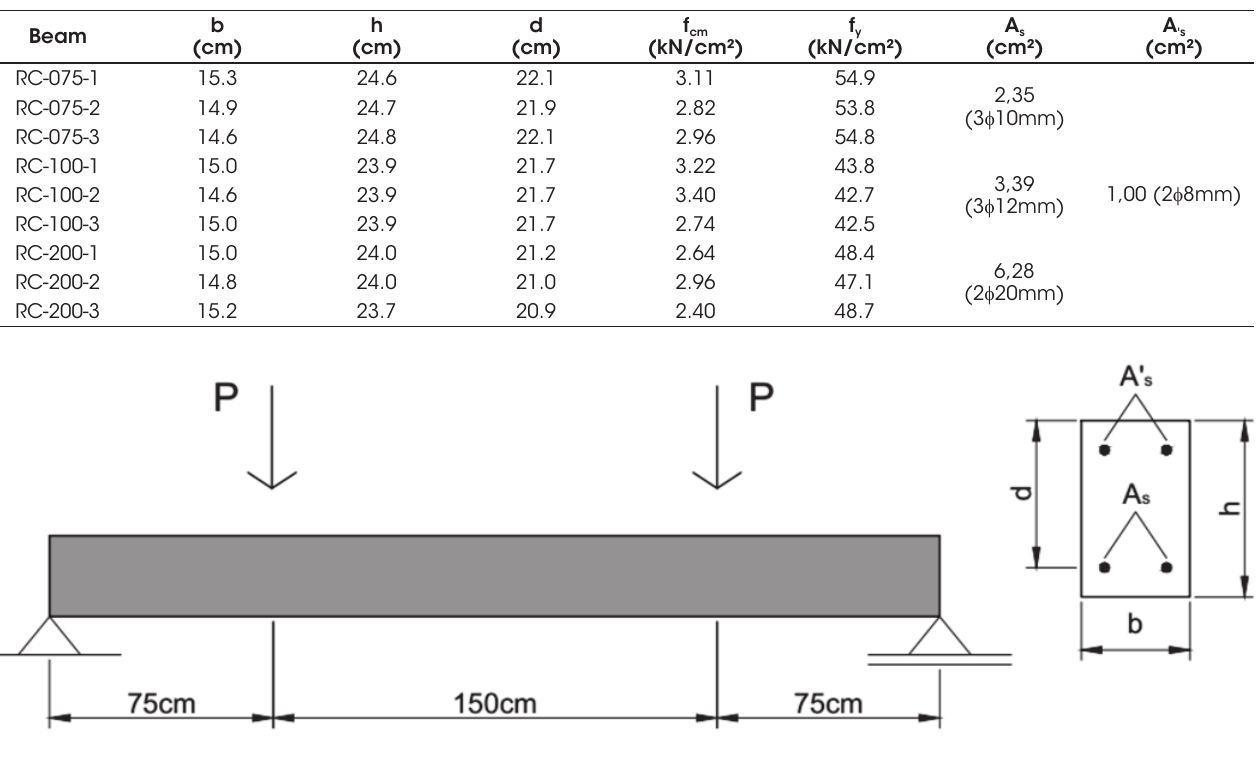
Geometry and loading of beams tested by Schegg and Decanini [8]